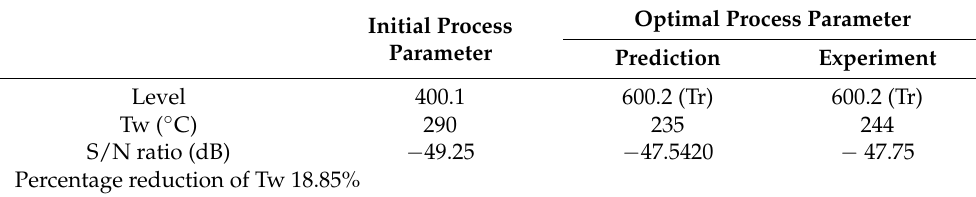
Table 11. Confirmation test results for center weld temperature.